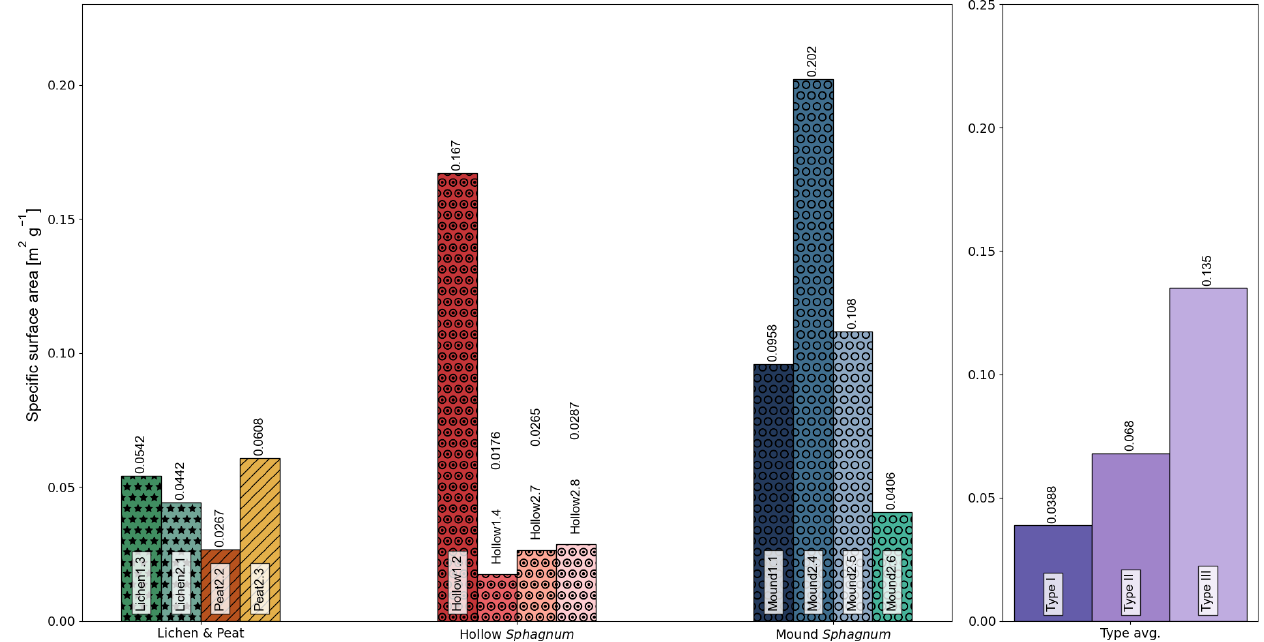
Figure 6. Specific surface area (m 2 g − 1 ) plots for each sample. Colors refer to each sample